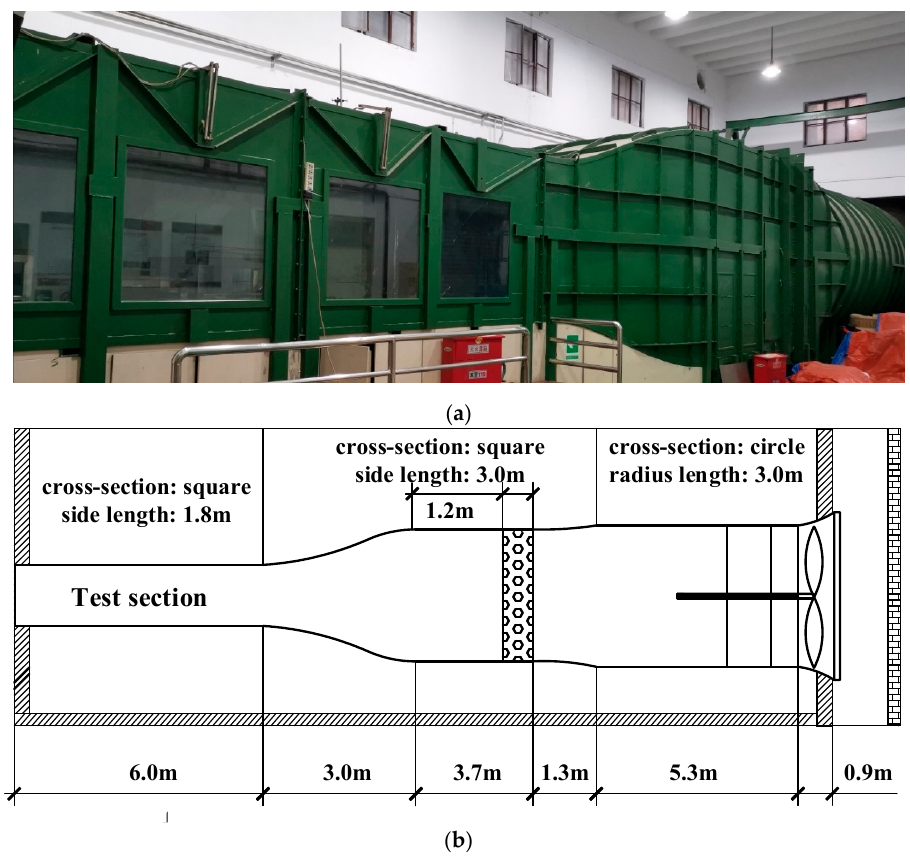
Figure 4. Schematic diagram of the wind tunnel: ( a ) wind tunnel; ( b ) dimensions of wind tunnel.